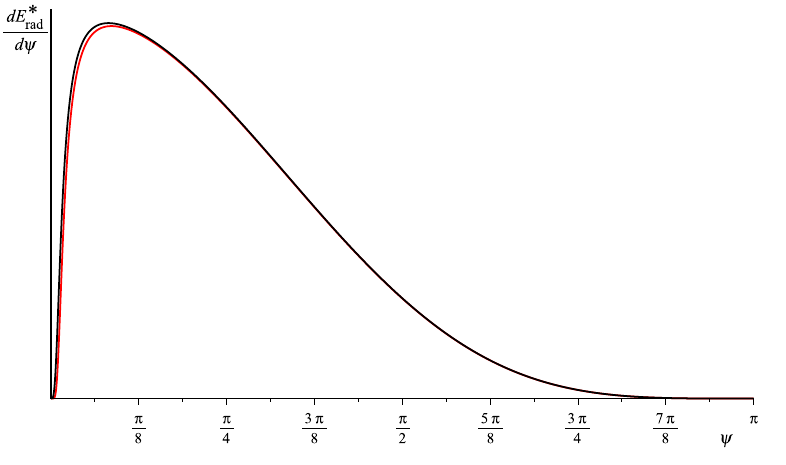
Figure 7 . The reduced angular distribution of the emitted radiation (red) versus the approximation by formula (6.21) (black) for D = 7 ; (cid:13) = 30. For higher values of (cid:13) two curves are more close to each